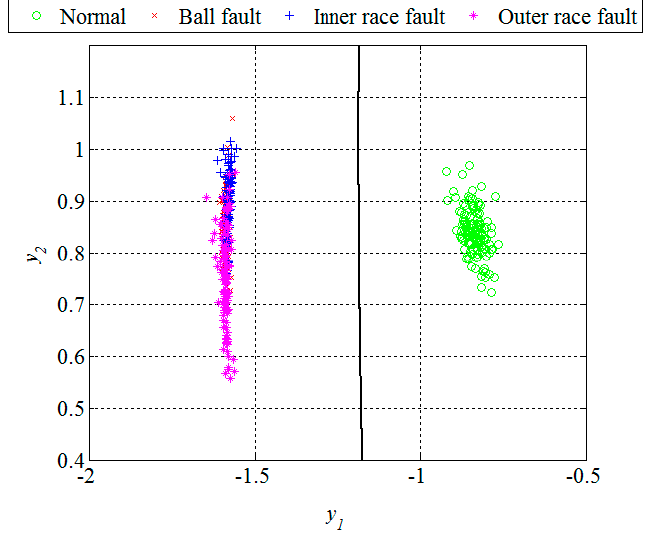
Figure 13. Dimension reduction and classification for the fault detection, segments of the testing set.